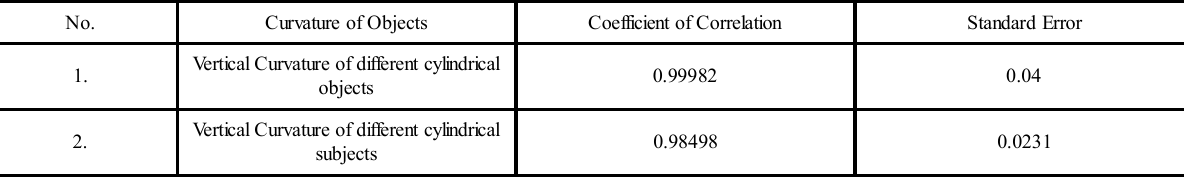
TABLE 4. COEFFICIENT OF CORRELATION AND STANDARD ERROR FOR CYLINDERS AND